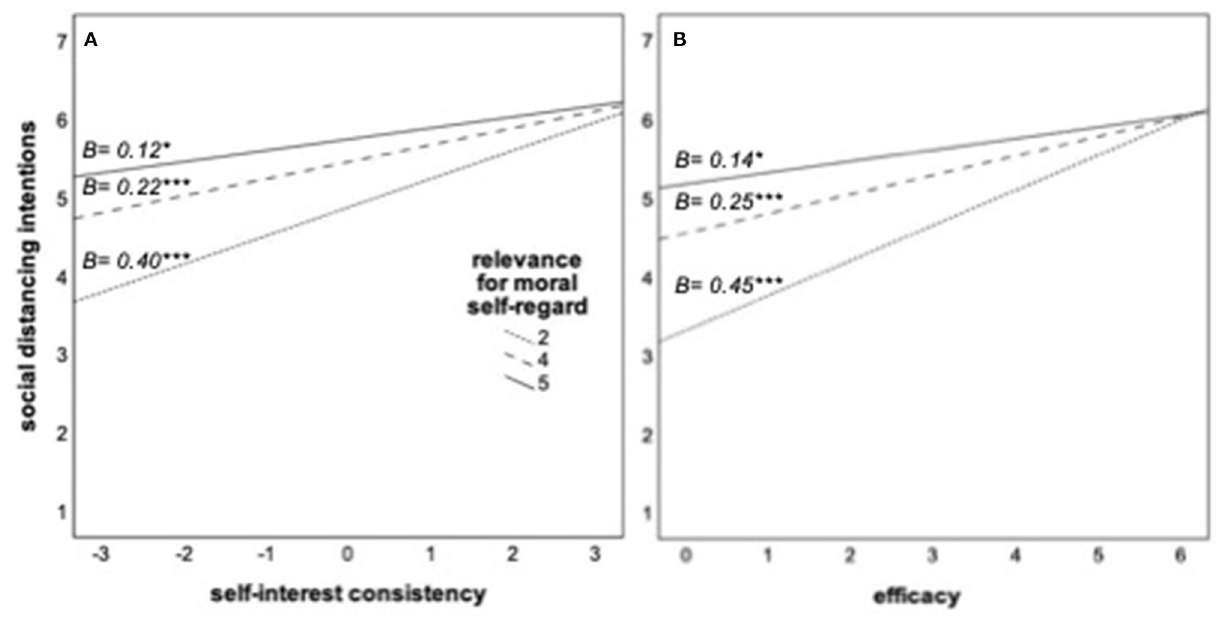
FIGURE 3 | (A,B) Role of self-interest consistency and efficacy of health measures for social distancing intentions at different levels of the relevance of complying for moral self-regard. The slopes represent the estimated conditional effects at the 16, 50, and 84th percentiles of the moderator. * p < 0.05; *** p <